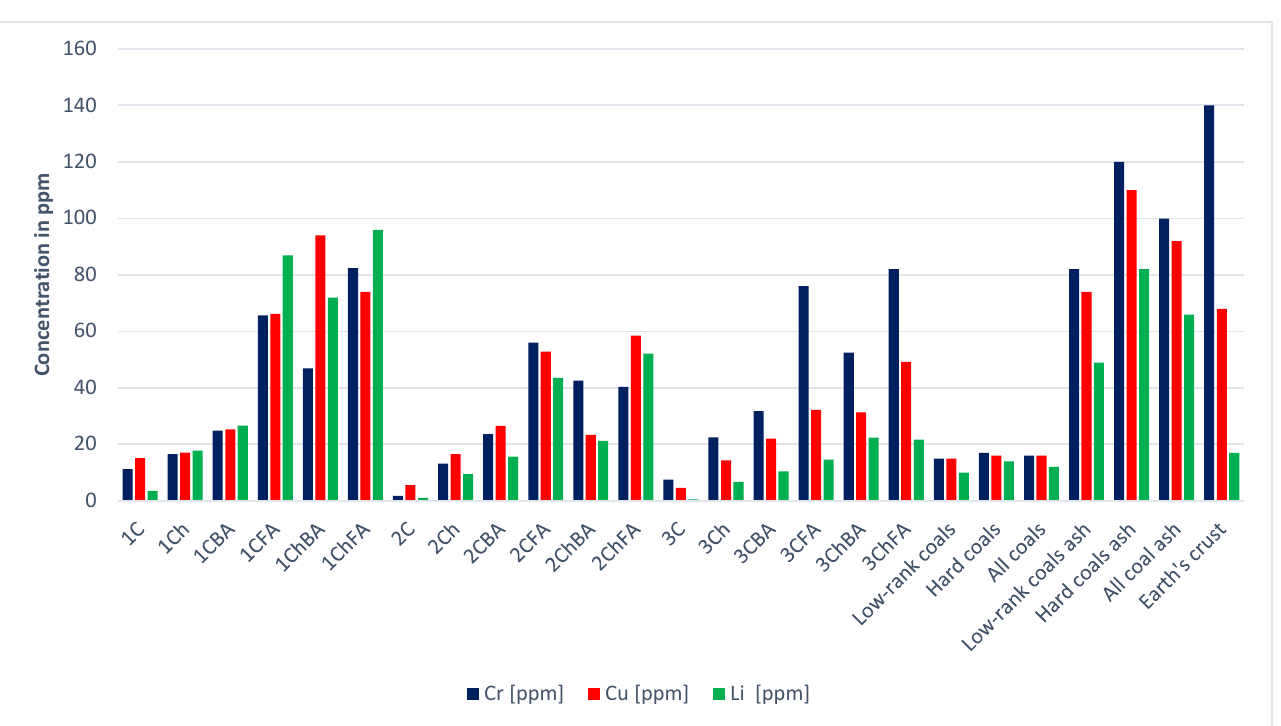
Figure 5. The Mo, Nb, and Sb content of coal, char, ashes and their Clarke values [21].